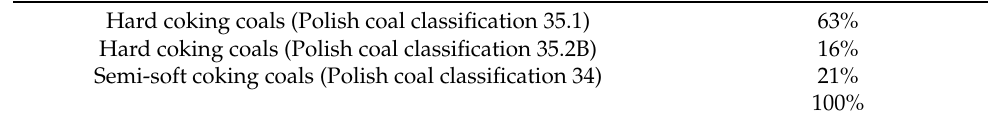
Table 4. Coal blend composition.